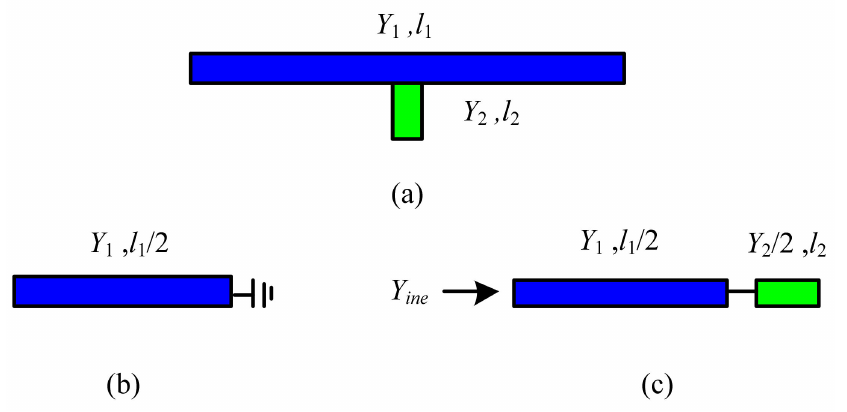
Figure 4. Configuration of the dual-mode microstrip resonator: ( a ) configuration; ( b ) odd-mode circuit model; ( c ) even-mode circuit